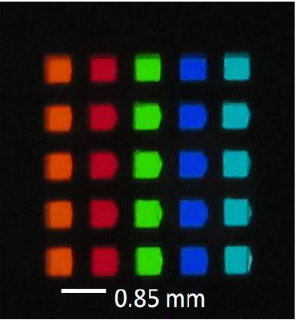
Figure 19. A close-up of the wavelength filter array.